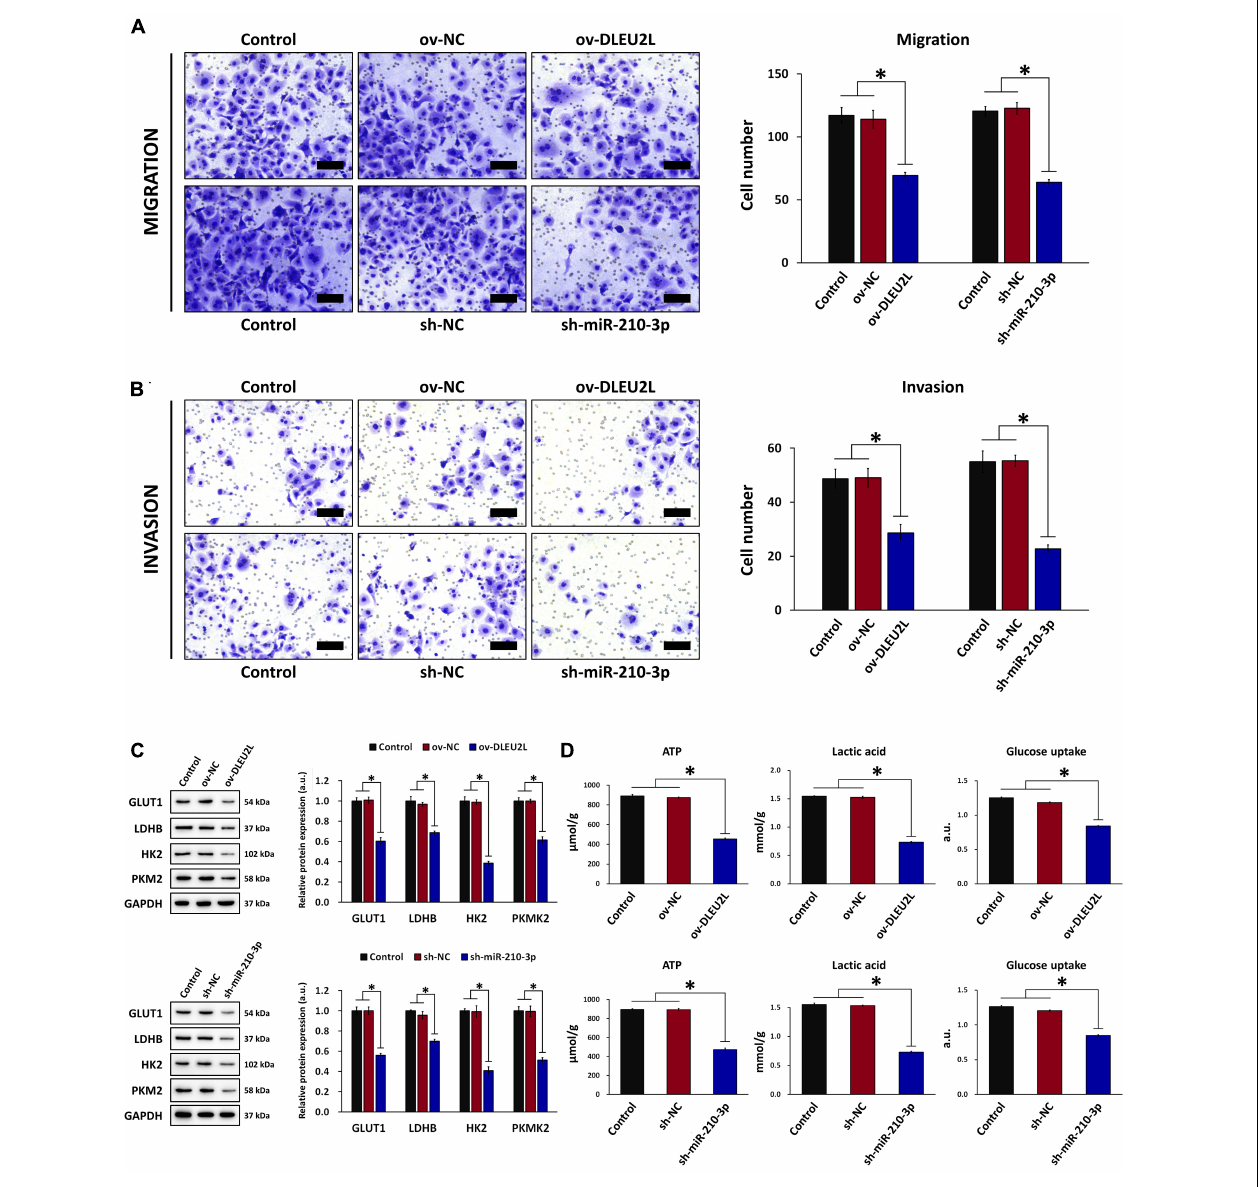
FIGURE 2 | Effect of DLEU2L overexpression and miR-210-3p silencing on PANC-1 cell migration/invasion and glucose metabolism. Transwell assay and quantification of the number of (A) migrating and (B) invading PANC-1 cells, transfected with DLEU2L overexpression (ov-DLEU2L) or miR-210-3p interference (sh-miR-210-3p) vectors (or the respective negative controls), after 24 h of culture. Scale bar, 100 µ m. (C) Western blot and quantification of the expression of proteins associated with glucose metabolism (GLUT1, LDHB, HK2, and PKM2), in PANC-1 cells transfected with DLEU2L overexpression (ov-DLEU2L) or miR-210-3p interference (sh-miR-210-3p) vectors (or the respective negative controls). (D) ELISA of ATP production, lactic acid production, and glucose uptake in PANC-1 cells transfected with DLEU2L overexpression (ov-DLEU2L) or miR-210-3p interference (sh-miR-210-3p) vectors (or the respective negative controls). All numerical data are expressed as the mean ± SD ( n = 3); ∗ p < 0.05. Statistical analysis was carried out using